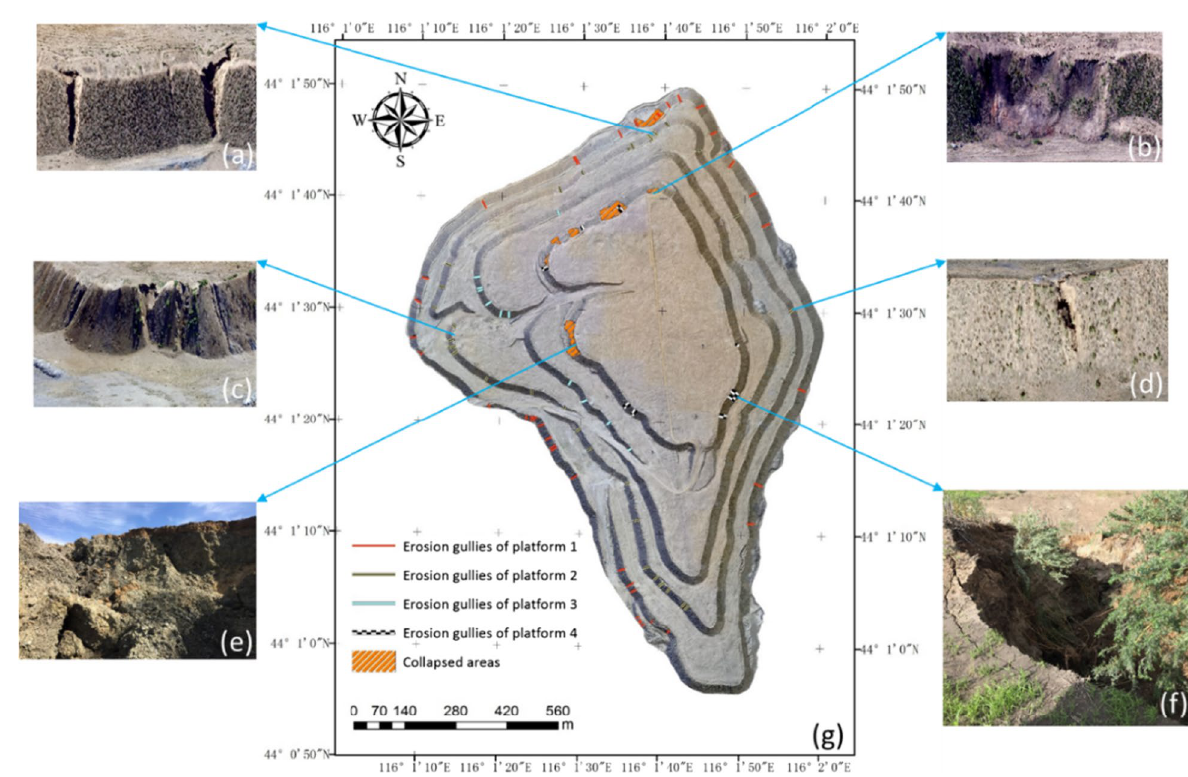
Fig. 9 Geologic hazards at north dump. a – d Hazards shown in 3D models; e – f Photos taken in the field; g Distribution of hazards